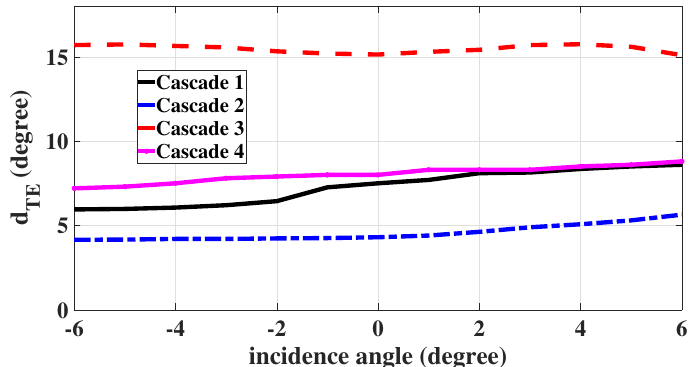
Figure 5. Trailing edge deviation angles for the 4 cascades from bladed